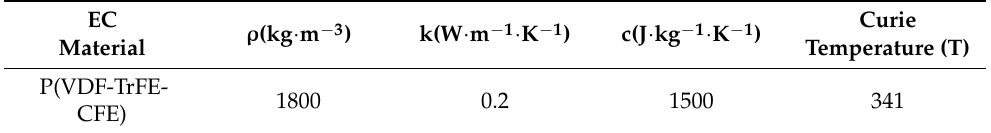
Table 1. Properties of P(VDF-TrFE-CFE) terpolymer